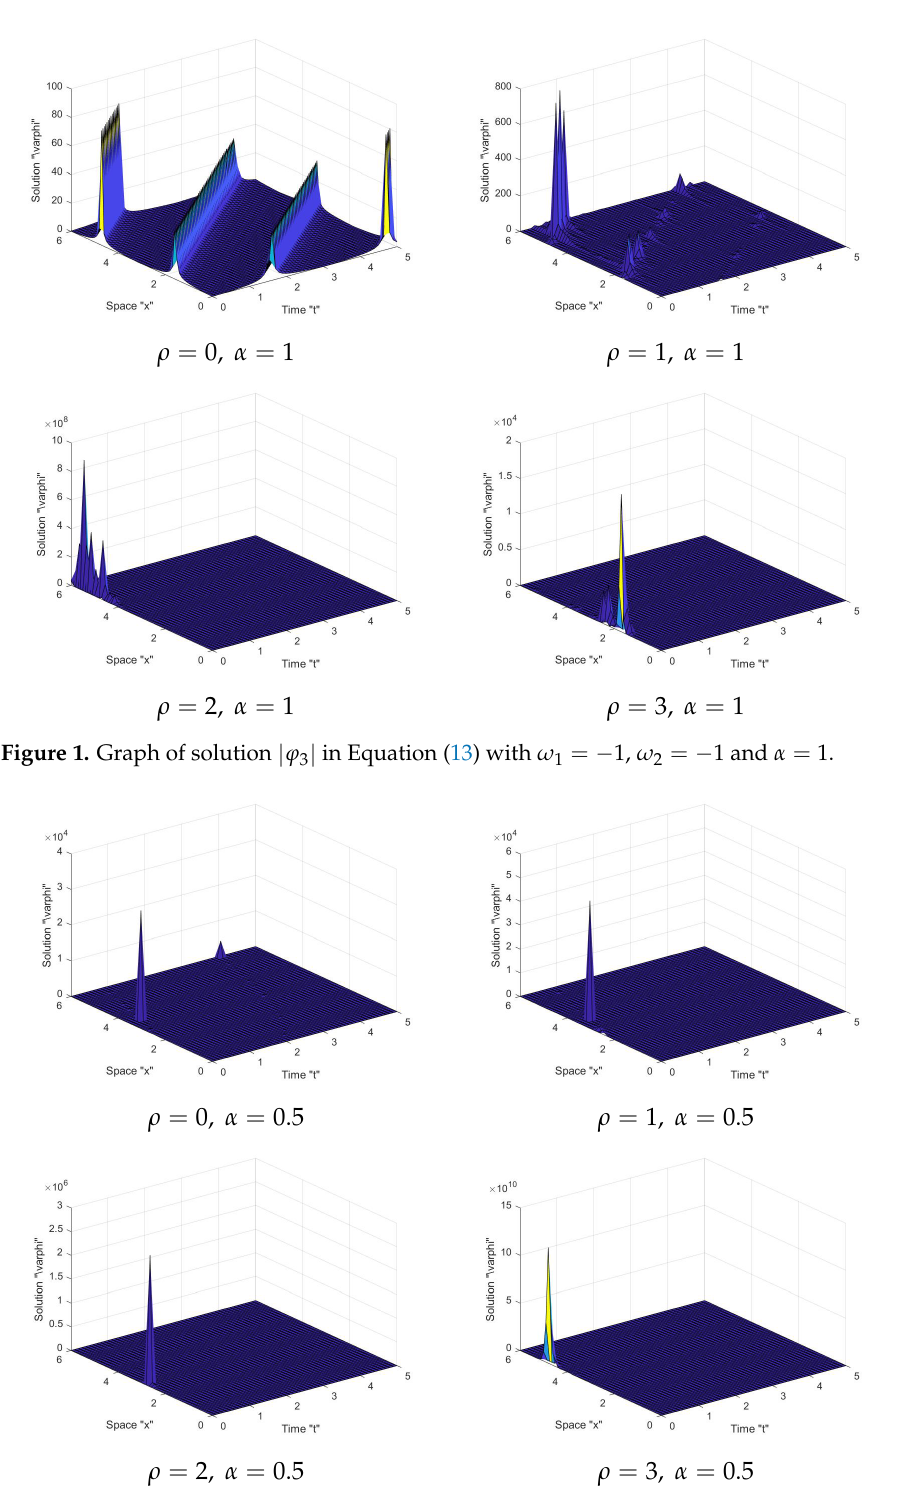
Figure 2. Graph of solution | ϕ 3 | in Equation (15) with ω 1 = − 1, ω 2 = − 1 and α =